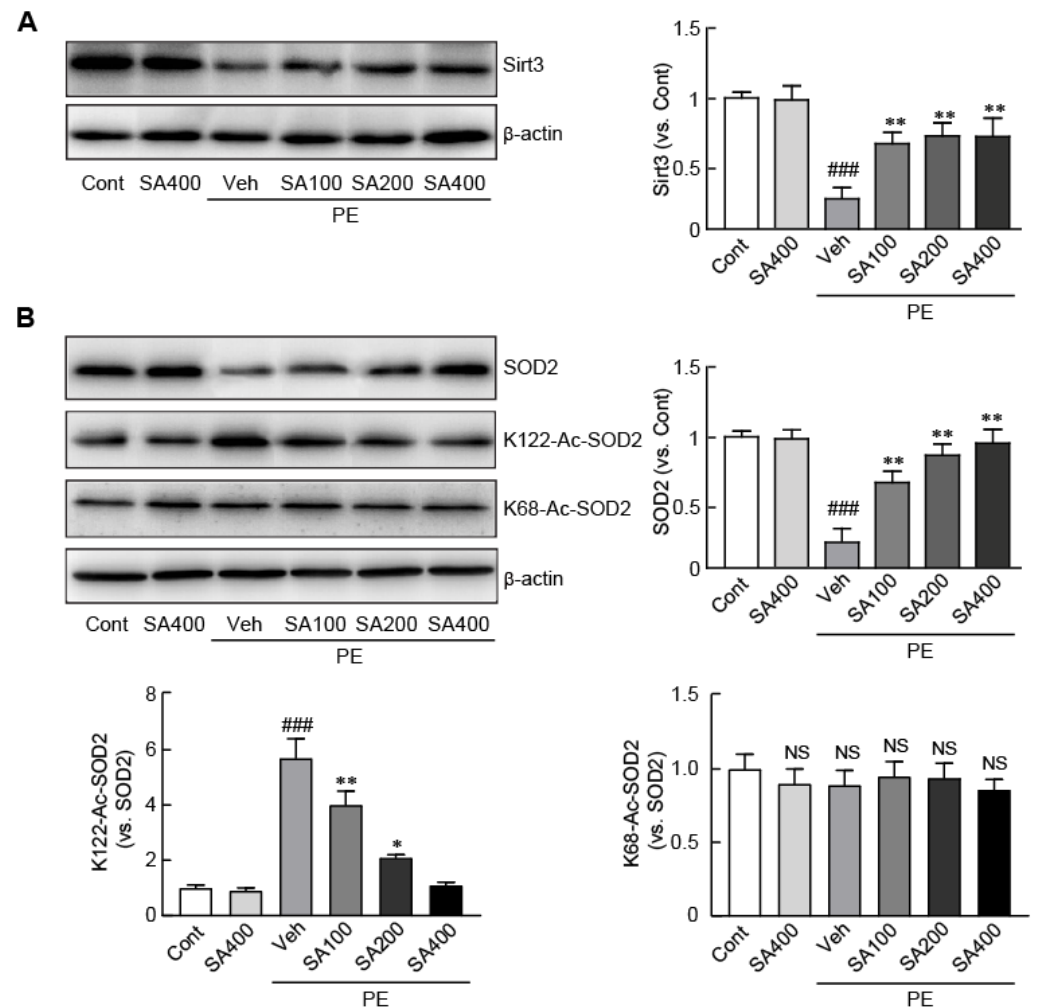
Figure 5. SA activates the Sirt3 / SOD2 signaling pathway in PE-stimulated hypertrophic cardiomyocytes. ( A ) The expression level of Sirt3 was measured by Western blot analysis. ( B ) The expression levels of SOD2 and acetylated SOD2 at the 122nd and 68th lysine residues were measured by Western blot analysis. The band densities were measured by using NIH ImageJ software. β -actin was used as a loading control. Data are expressed as the mean ± standard error of the mean (SEM). Significance was assessed by one-way analysis of variance (ANOVA) with a Bonferroni post hoc test. ### P < 0.005 vs. the control group; * P < 0.05, ** P < 0.01, and *** P < 0.001 vs. the PE-only treated group. NS, not significant; K-122-Ac-SOD2, acetylation at the 122nd lysine residue of SOD2; K-68-Ac-SOD2, acetylation at the 68th lysine residue of SOD2; Veh, vehicle-treated; SA100, SA200, and SA400, 100, 200, and 400 µ